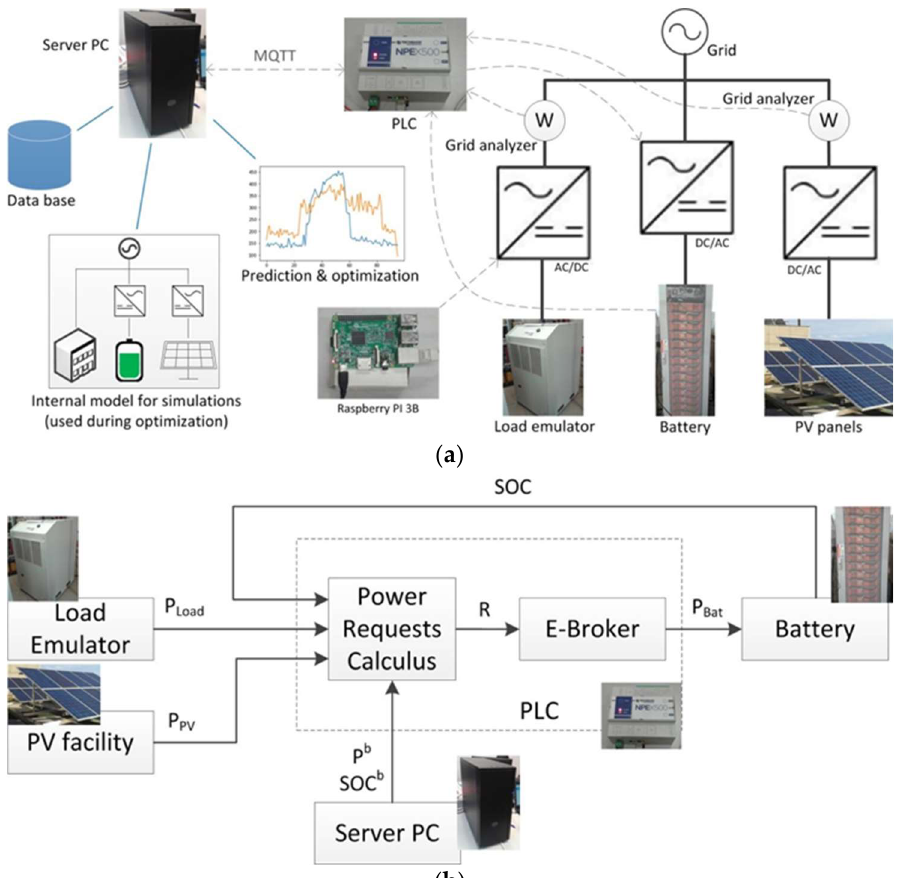
Figure 5. Schemes of the test bench. ( a ) Devices and connections scheme. Black bold solid lines represent electrical connections, gray dashed lines represent communications and blue thin solid lines represent PC functions ( b ) Control scheme of the RT decision